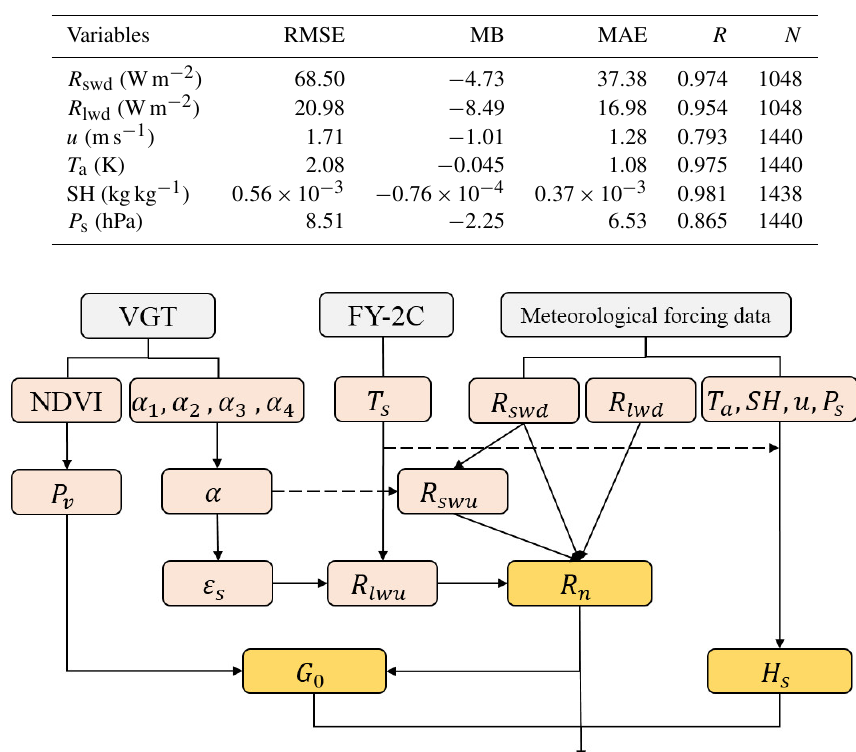
Table 3. Validation of the forcing data.